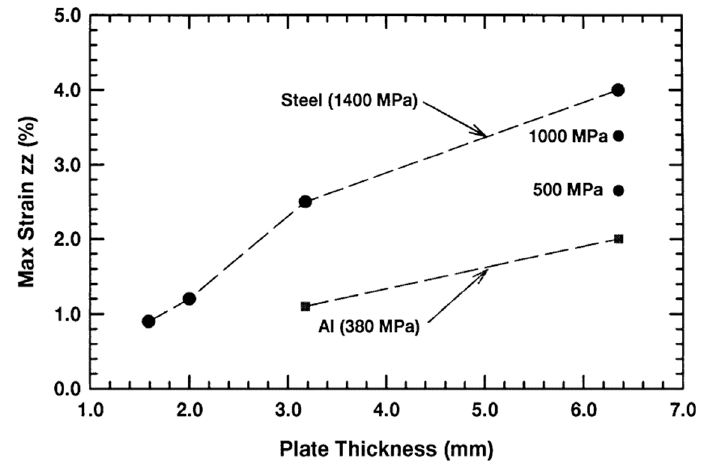
Figure 4. Maximum strain in the projectile core versus target thickness [26]. Reprinted with per-